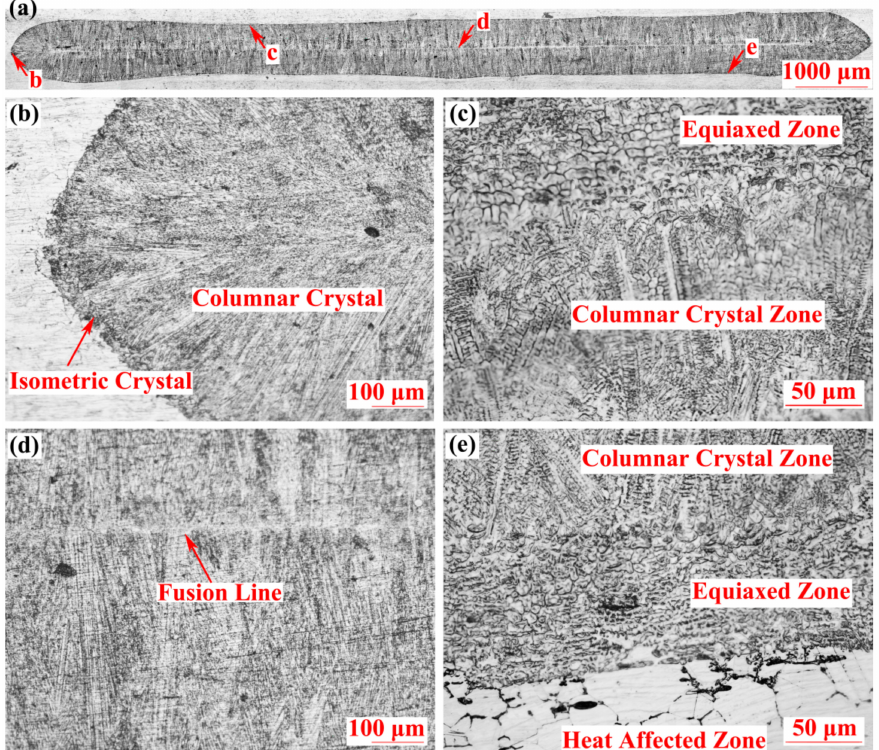
Figure4. Metallographicmorphologyofnuggetonthetransversecuttingsection: ( a )overallperspective, ( b ) morphology on the nugget end, ( c ) morphology on the nugget upper side, ( d ) morphology on the fusion zone, and ( e ) morphology on the nugget lower